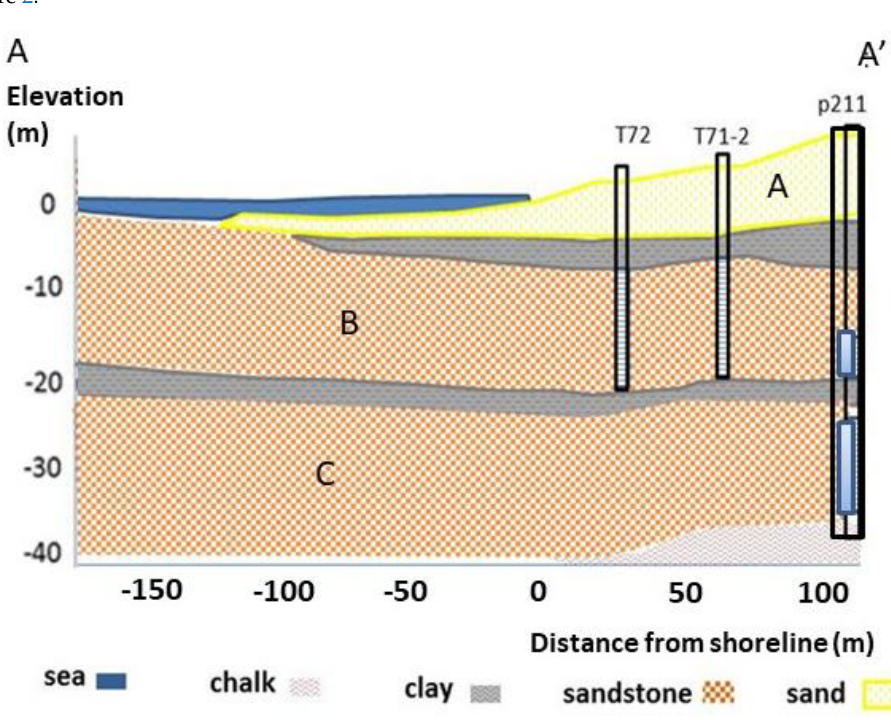
Figure 2. Geological section and wells’ locations (see location in Figure 1). Well screenings are colored in light blue.